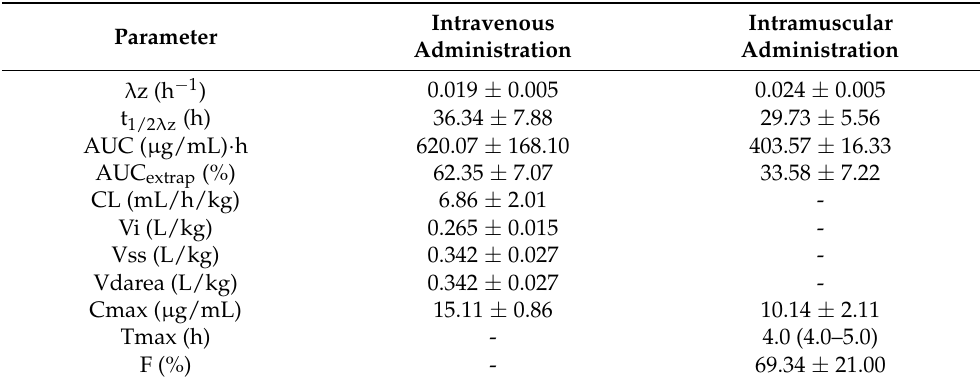
Table 4. Mean ± SD (standard deviation) values of the main pharmacokinetic parameters estimated by the non-compartmental approach, after intravenous and intramuscular administration of 4 mg/kg CP to